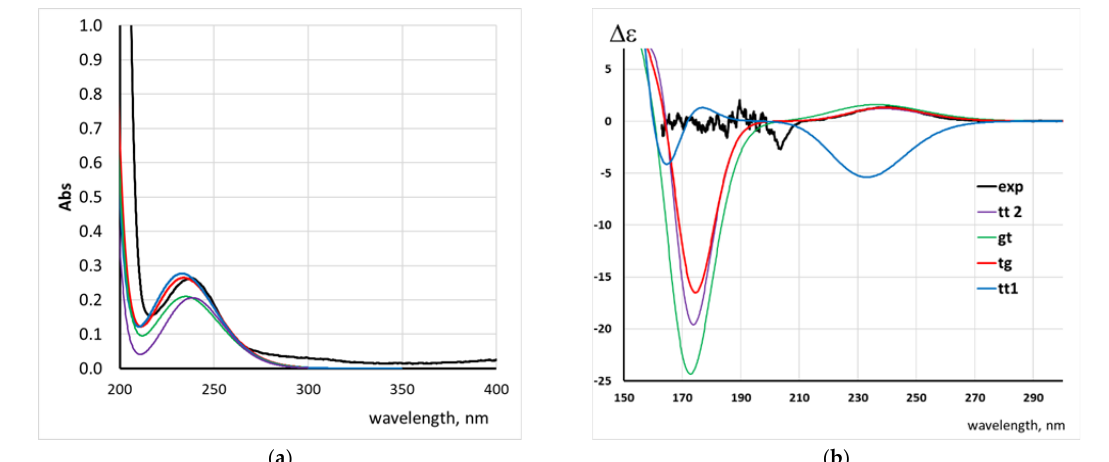
Figure 1. UV/Vis ( a ) and ECD ( b ) spectra of CPDA in ethanol at 25 °C. Experimental (black) and calculated conformers (color). Figure 1 reveals a low sensitivity of UV/Vis spectra to conformational changes in camphorodiimine, which is confirmed by TD-FT calculations (Table S3), but significant differences are observed in the ECD spectrum, indicating a change in the sign of CD in the trans-trans conformer (tt-1) compared to other stable structures (Table 1). This allows to exclude tt-1 from further consideration. As for the rest of the conformers, the signs of the CD bands for them coincide with those obtained experimentally (Figure 1). The dis- crepancy in the short wavelength region between the experimental and calculated CD spectra in Figure 1b may be related to the difficulty in obtaining precise spectra in the vacuum ultraviolet range of shorter than 220 nm due to the light source, the absorption by solvent, and the sample cell spectra. For the conformers tt-2, tg and gt it is necessary to use other relevance criteria. Another fundamental characteristic of optically active sub- stances is the specific angle of optical rotation [α], t he experimental value of which for CPDA, as well as the calculated values for conformers are given in Table.1. These data indicate that the [α] values for the gt and tt -2 conformers, although they coincide in sign with the experimental value ( − 29.6°), are much higher than the later. The highest agree- ment is observed for the tg ( − 30.7°) conformer, which also has the lowest energy. Taking into account the presence of local dipoles of molecular moieties in the CPDA, primarily, the C=N imine bond, it was of interest to calculate the dipole moments of the conformers and compare them with the experimental value. These data (Table 1 and Figure 2) indicate that the presence of one gauche confor- mation in the aliphatic linker leads to a change in the direction of the resulting dipole moment from mutually perpendicular with respect to the long molecular axis to predom- inantly mutually parallel (Figure 2). At the same time, the value of the dipole moment of the tg conformer 2.29 D is closest to the experimental value 3.15 D (Table 1).